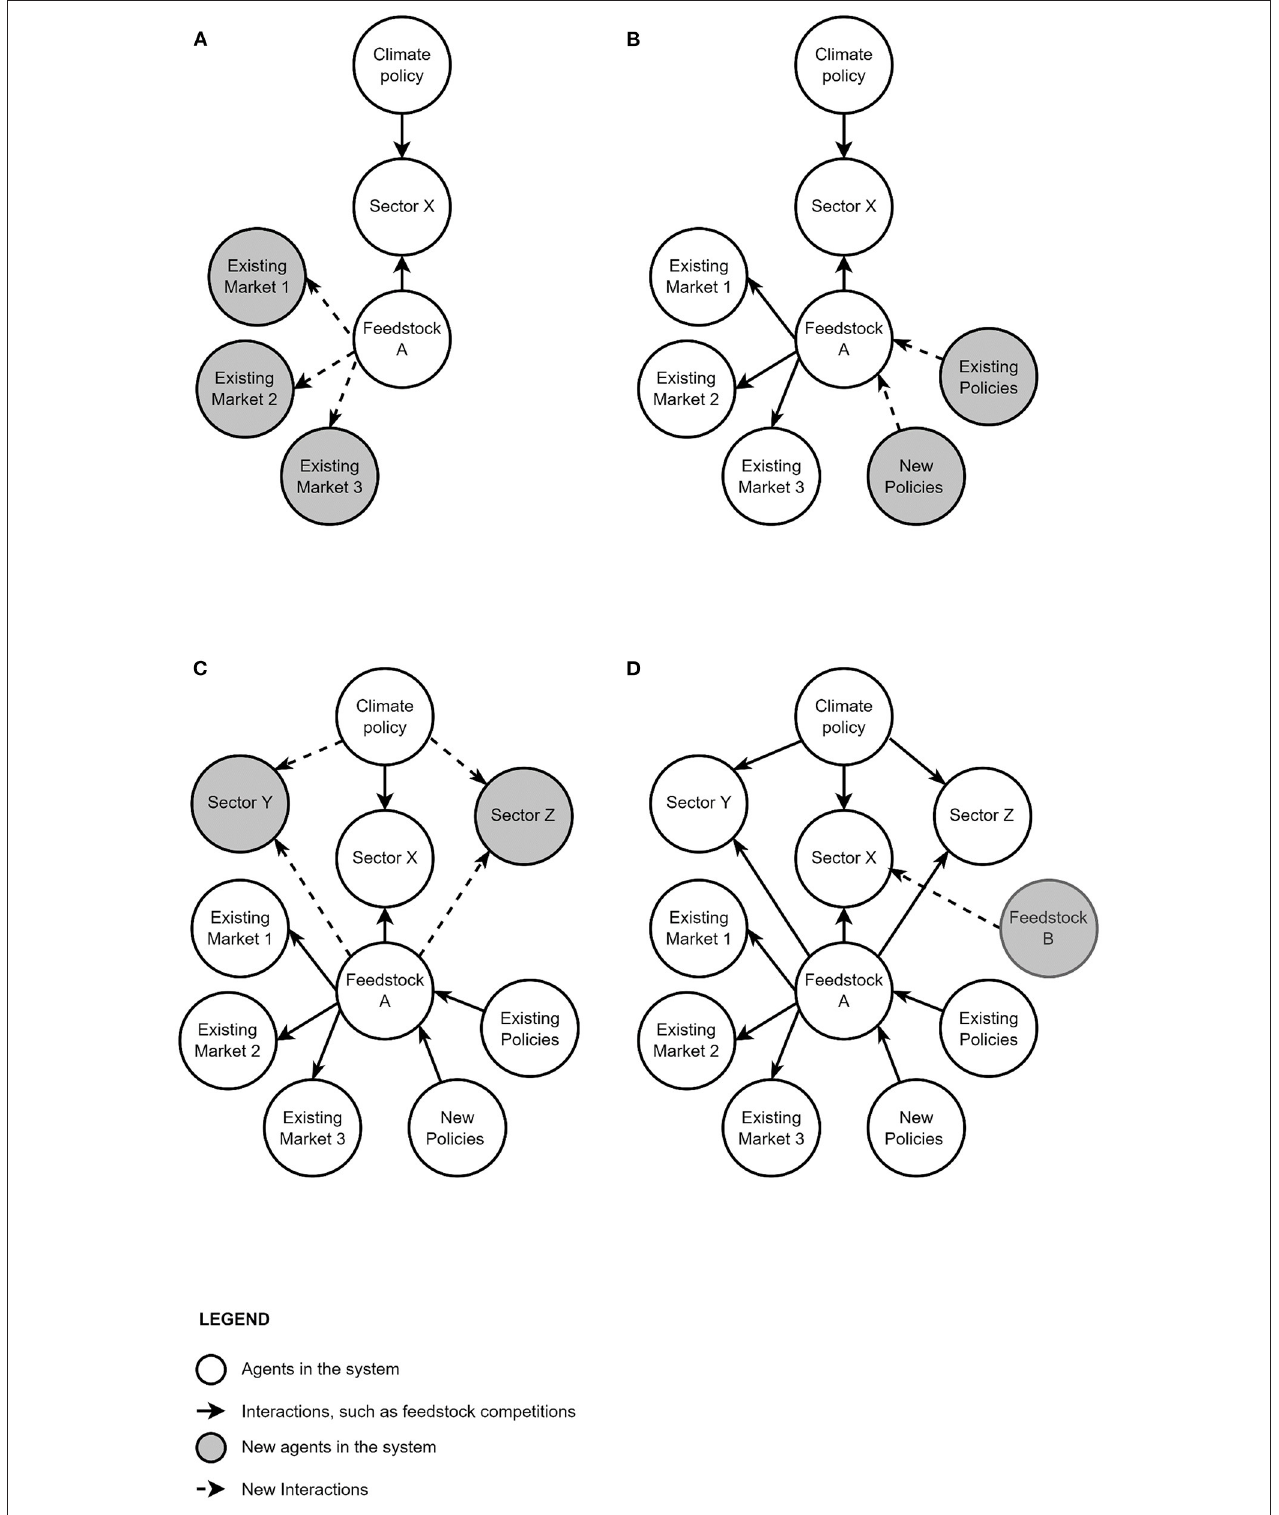
FIGURE 2 | An application of a STS approach to assess feedstock types and availability. (A) Interactions between feedstock and existing markets; (B) Interactions between feedstock and policies; (C) Interactions between feedstock and other emerging sectors; (D) Inclusion of new feedstock alternative.